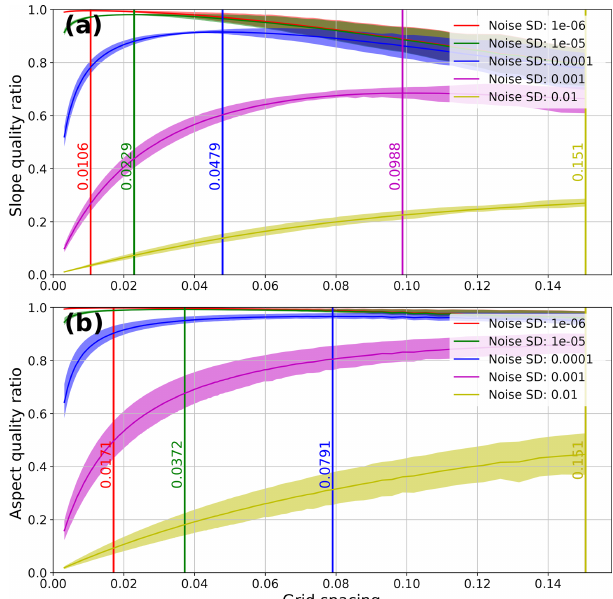
Figure 6. Gaussian hill slope (a) and aspect (b) QRs vs. grid spac- ings for a range of noise levels (1 e − 2 to 1 e − 6 ). The 25th–75th per- centile QRs are shaded for each noise level. Optimal grid spacings (maximum QR) for each noise level are marked with vertical lines. Slope calculations result in lower optimal grid spacings compared to aspect. Higher noise levels lead to higher optimal grid spacings for both slope and aspect calculations. Note that the purple and yel- low lines in panel (b) have the same optimal grid spacing, and thus only the yellow line is